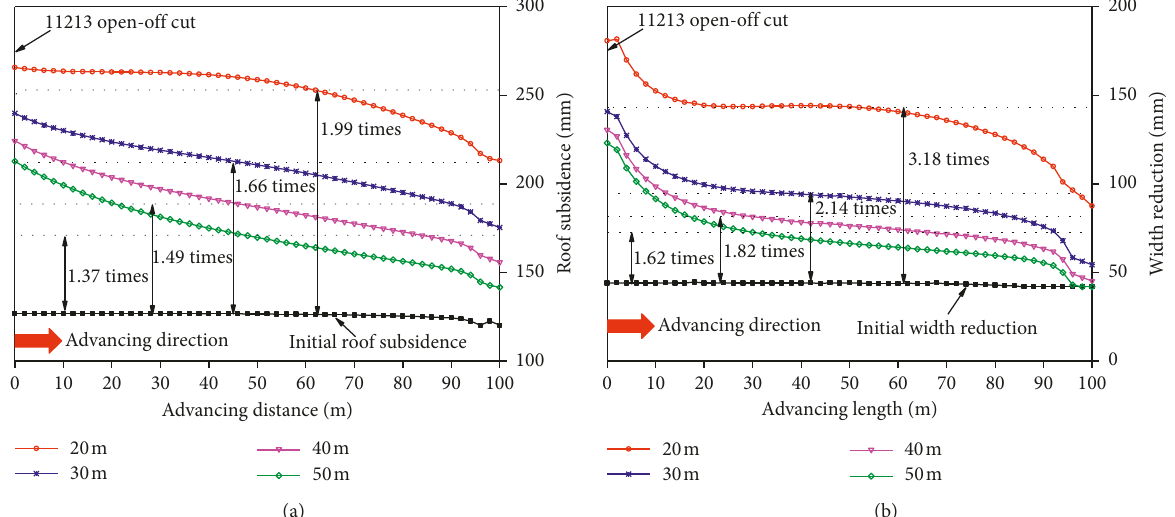
Figure 17: Deformations at different widths of the chain pillar. (a) Roof subsidence. (b) Width reduction.